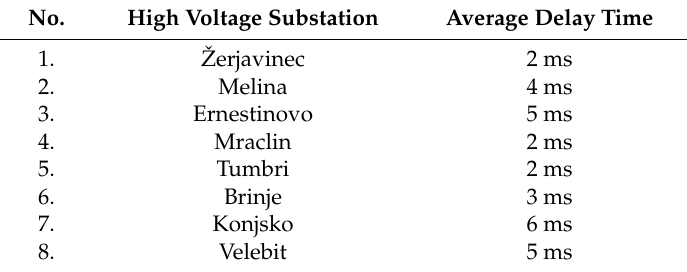
Table 1. Phasor measurement units (PMUs) measurement data packet transfer delay (for a path of max 300 km).